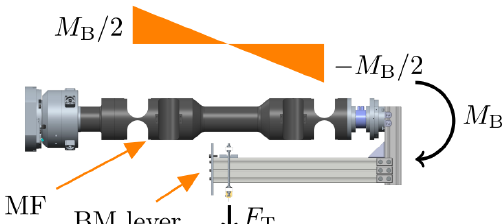
Figure 5. Working principle of